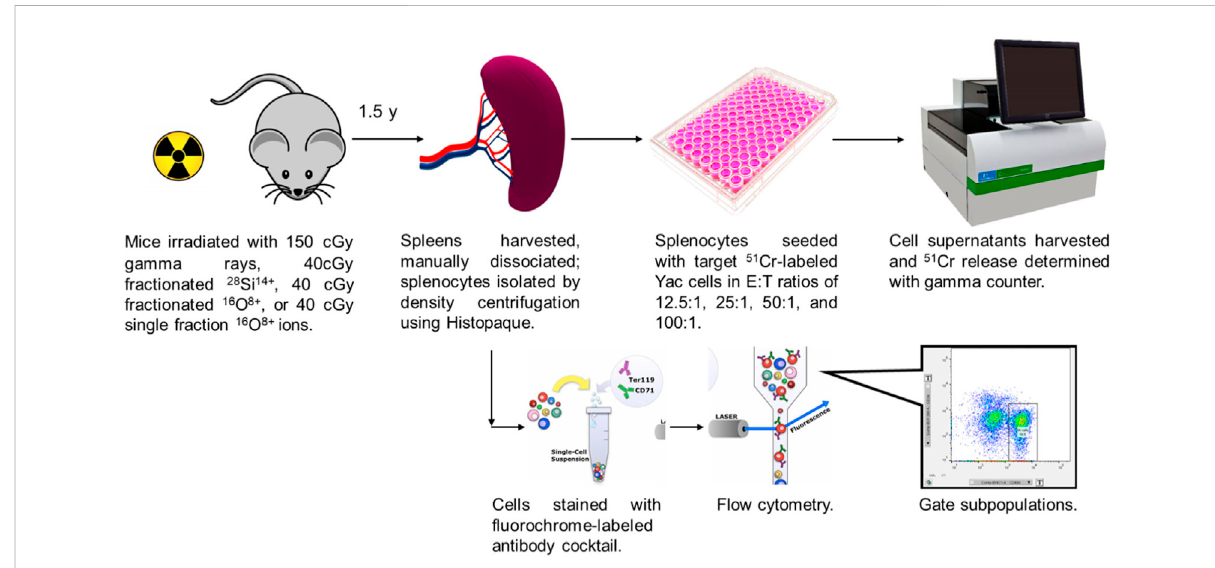
FIGURE 1 Experimental design.